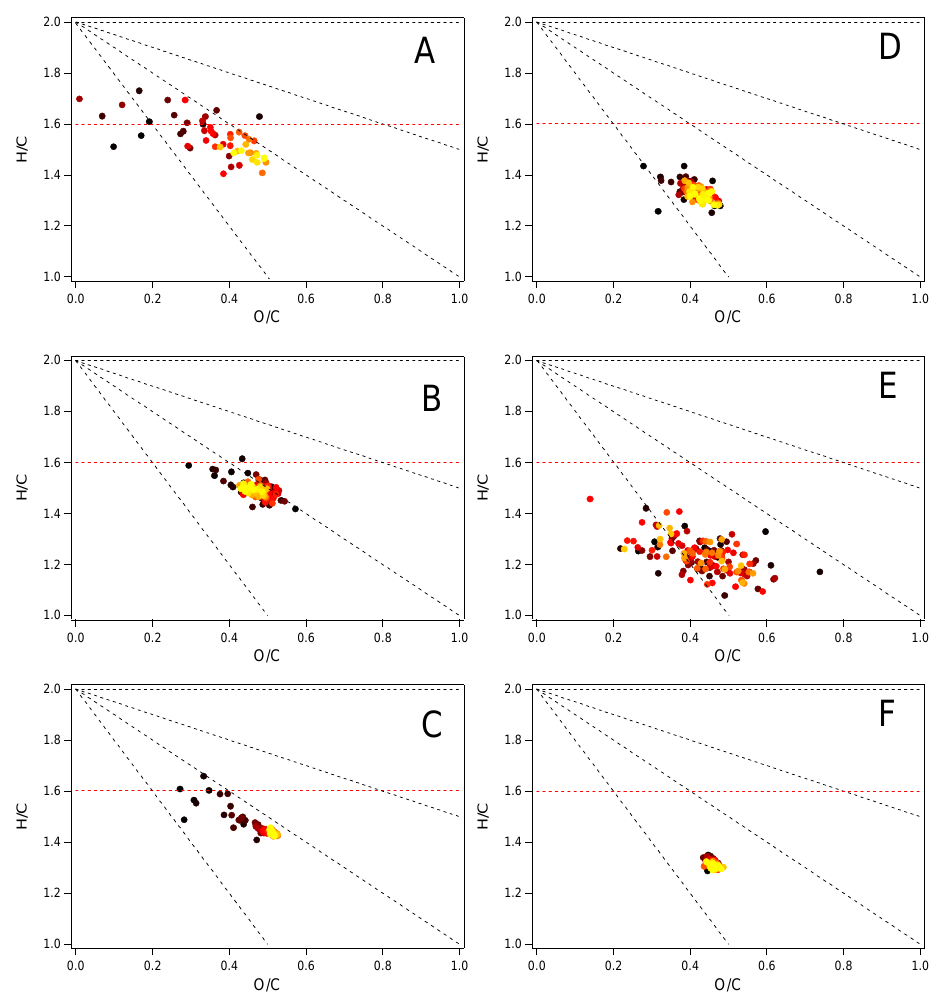
Figure 6. H / C and O / C ratios of SOA from the OH oxidation and ozonolysis of α -pinene (a, d) , β -pinene (b, e) and limonene (c, f) . The left panels are from OH oxidation and right panels from ozonolysis. Dark color denotes the beginning of the experiments and yellow denotes the later period. The red dashed line correspond to H / C = 1.6. The black dashed lines correspond to the slope of − 2, − 1 and − 0.5.